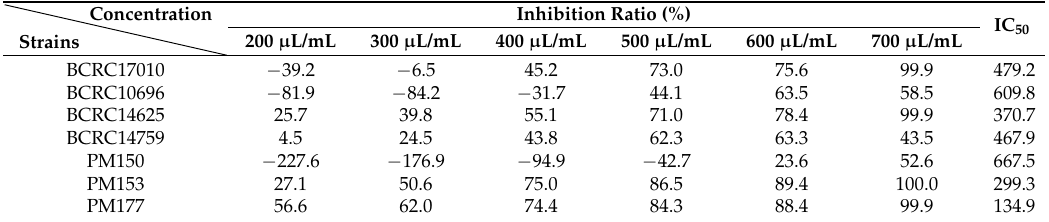
Table 3. The inhibitory effects of lactic acid bacteria cell free supernatant on the growth of HT-29 cell line for 24 h using MTT assay.